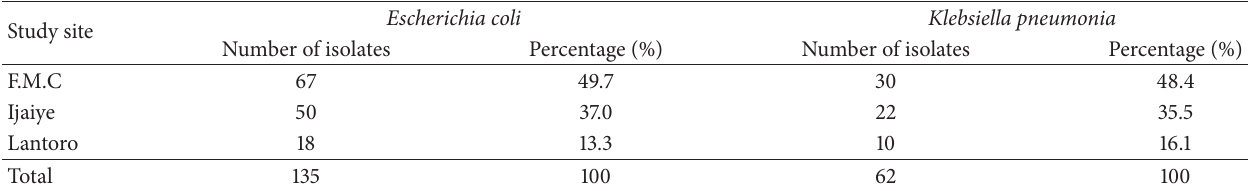
Table 1: Frequency of isolates ( 𝑛 = 197 ) in relation to sites.